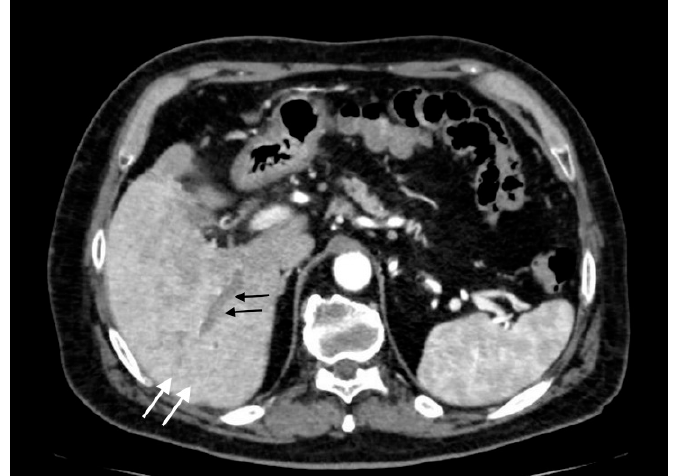
Figure 10. Right portal vein thrombosis: extensive right portal vein hypodensity subsequent to an intraluminal thrombus formation (black arrows) with hepatic hyperemia (white arrows).